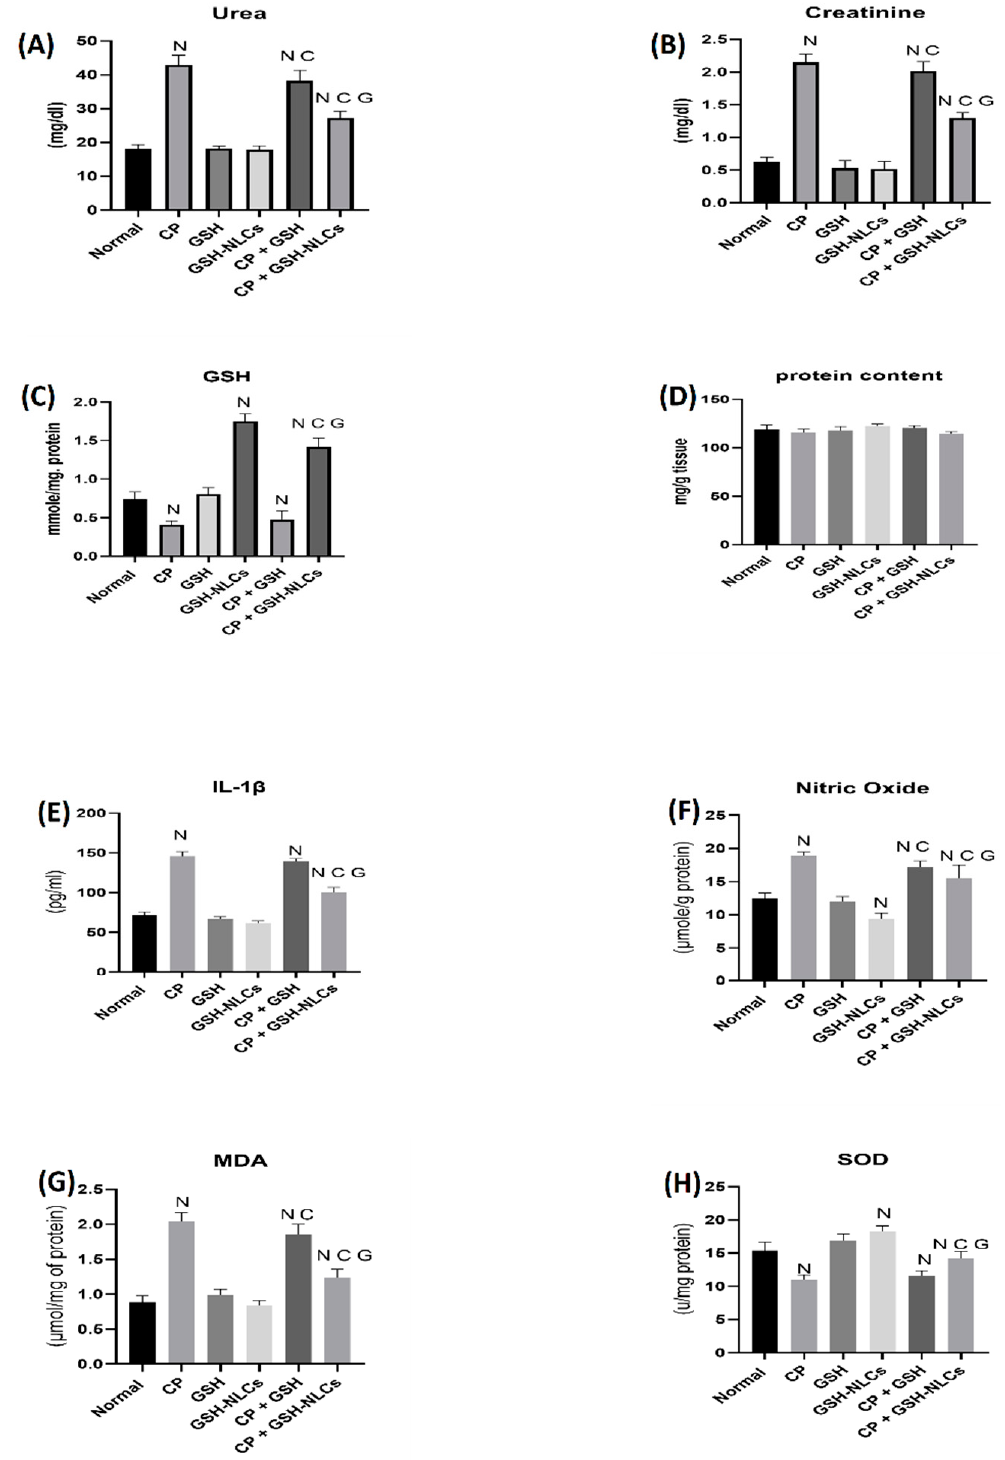
Figure 6. Variations in the levels of biochemical parameters in the normal, injured, and treated animal groups whereas ( A ) urea, ( B ) creatinine, ( C ) GSH, ( D ) protein, ( E ) IL-I β , ( F ) nitric oxide, ( G ) MDA, and ( H ) SOD levels in different groups. (N: significantly different than normal; C: significantly different than CP; G: significantly different than the CP + GSH group).